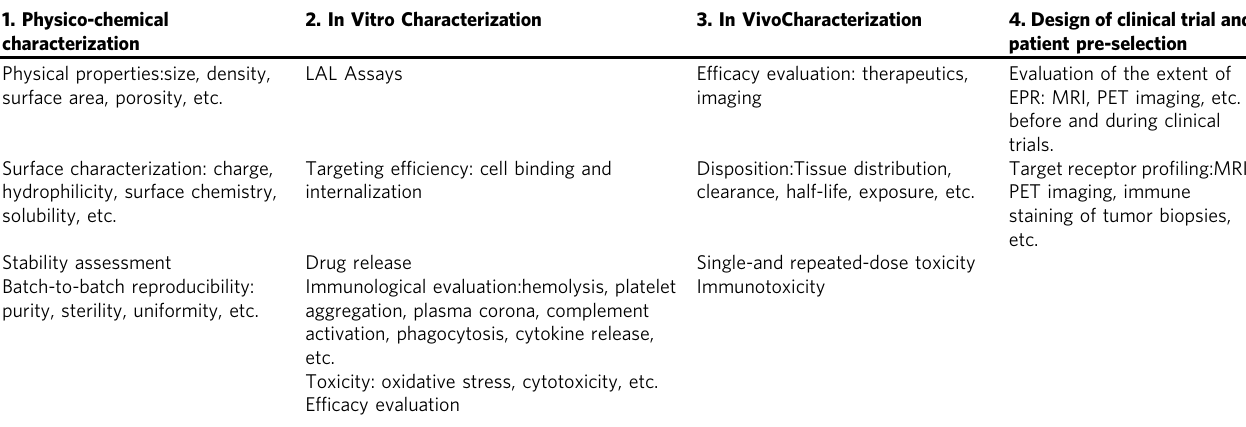
Table 1 Bridging the bench-bed gap. Summary of the key pre-clinical characterizations included in the standardized analytical cascade set by the Nanotechnology Characterization Lab (NCL) to guide both academic and non-academic research labs to gather required data for fi ling an investigational new drug application to the